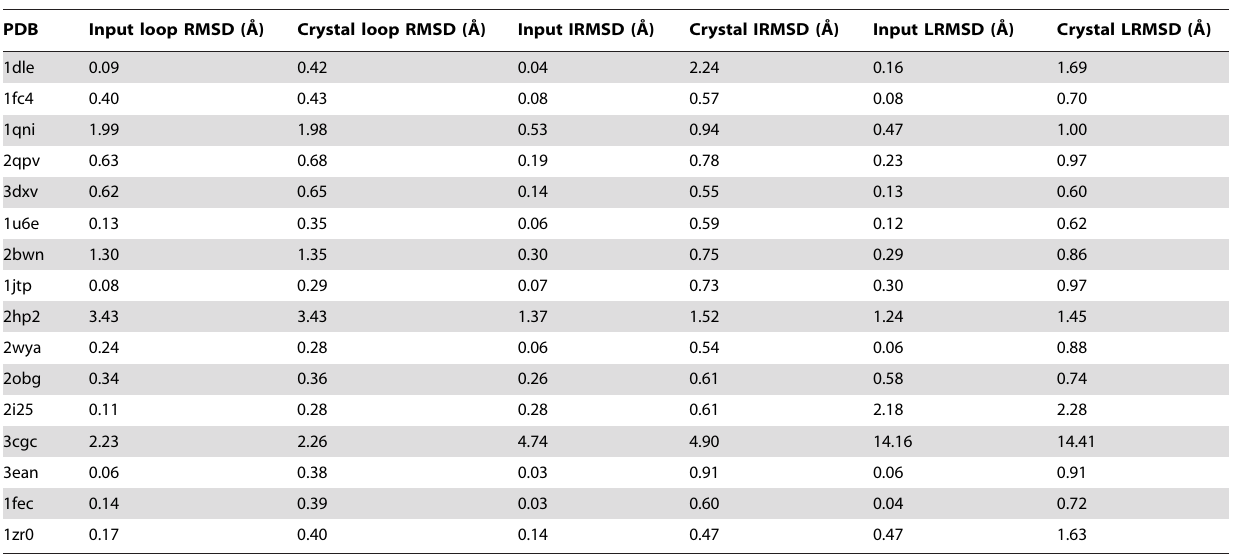
Table 3. RMSD of lowest-scoring models.